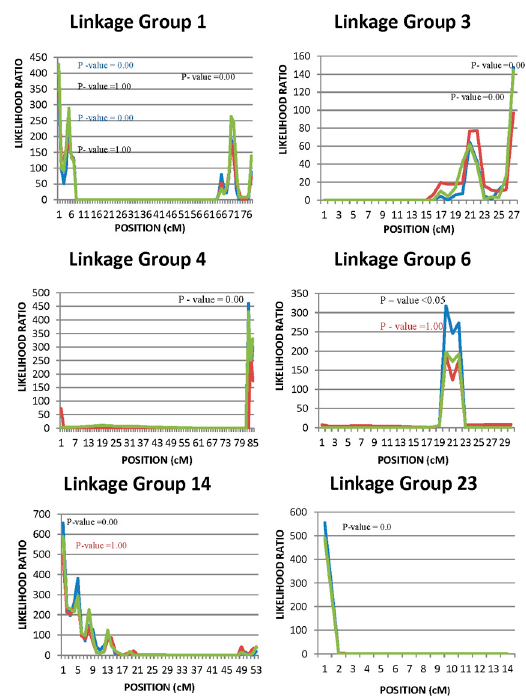
Figure 2. Quantitative trait loci (QTL) analysis (using a mixed model which includes a polygenic component) of cortisol, glucose, and lysozyme in different linkage groups. Blue, red, and green lines represent likelihood ratios of cortisol, glucose, and lysozyme levels, respectively. Blue, red, and green p -values represent significance of cortisol, glucose, and lysozyme levels, respectively. Black color represents significance of all traits.